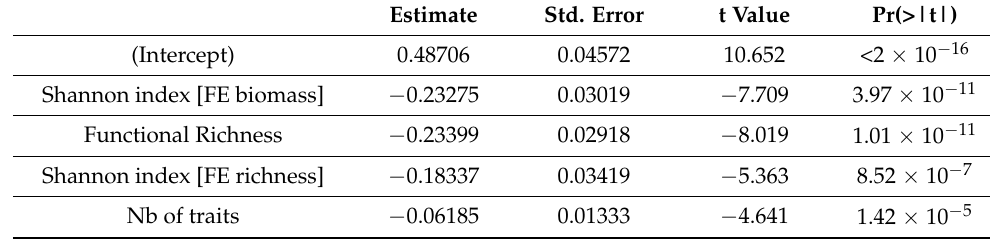
Table 4. Results of the ANCOVA performed on the linear model. Adjusted R 2 [acoustic model] ~ type of functional descriptor + Nb of traits.